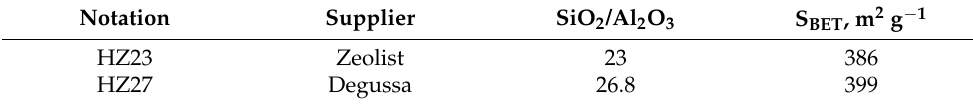
Table 1. Notations and some characteristics of the parent H-ZSM-5 zeolites.